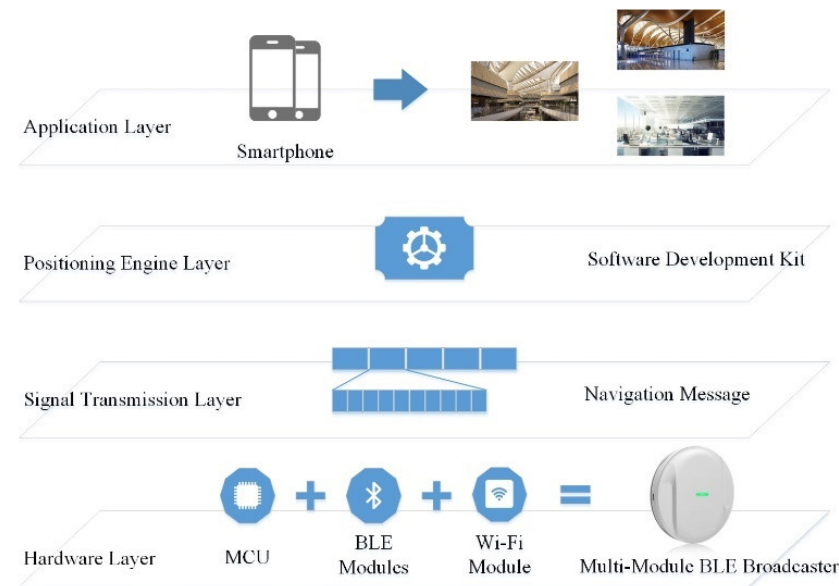
Figure 1. The architecture of the MMBB-based indoor positioning system.